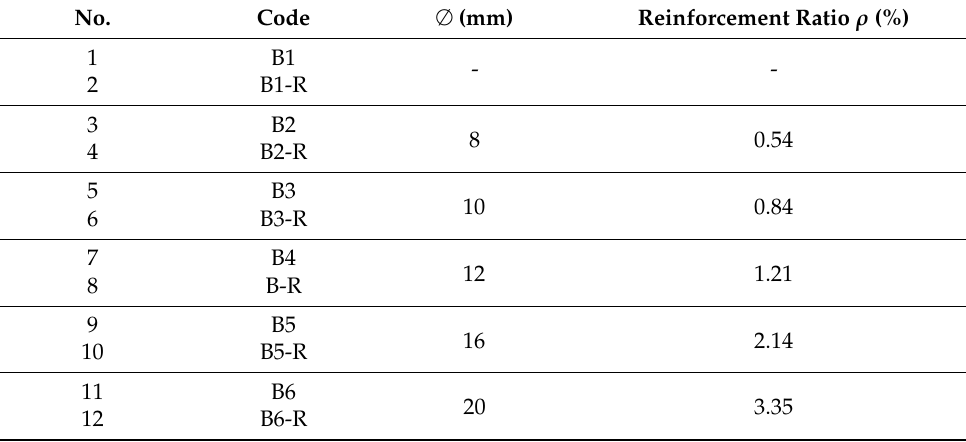
Table 5. Reinforcement details for beam